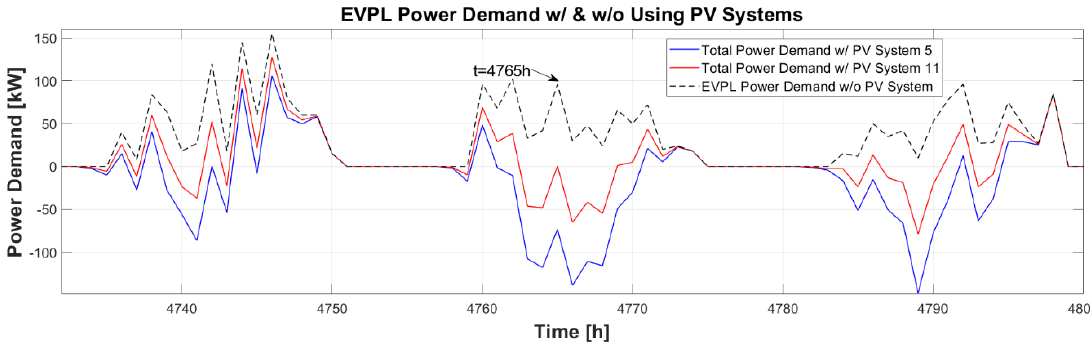
Figure 12. EVPL power demand for three cases, without PV system (dashed black curve), with PV system #5 (blue line), and with PV system #11 (red curve).